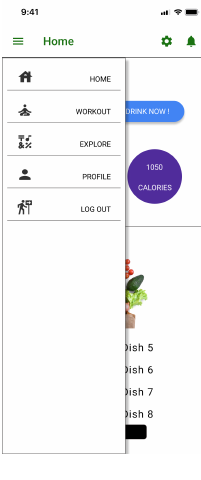
Figure 6. Registration, Screen Figure 7. Home Screen